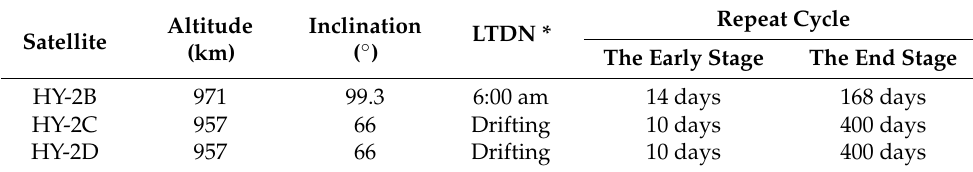
Table 1. Main parameters of the HY-2